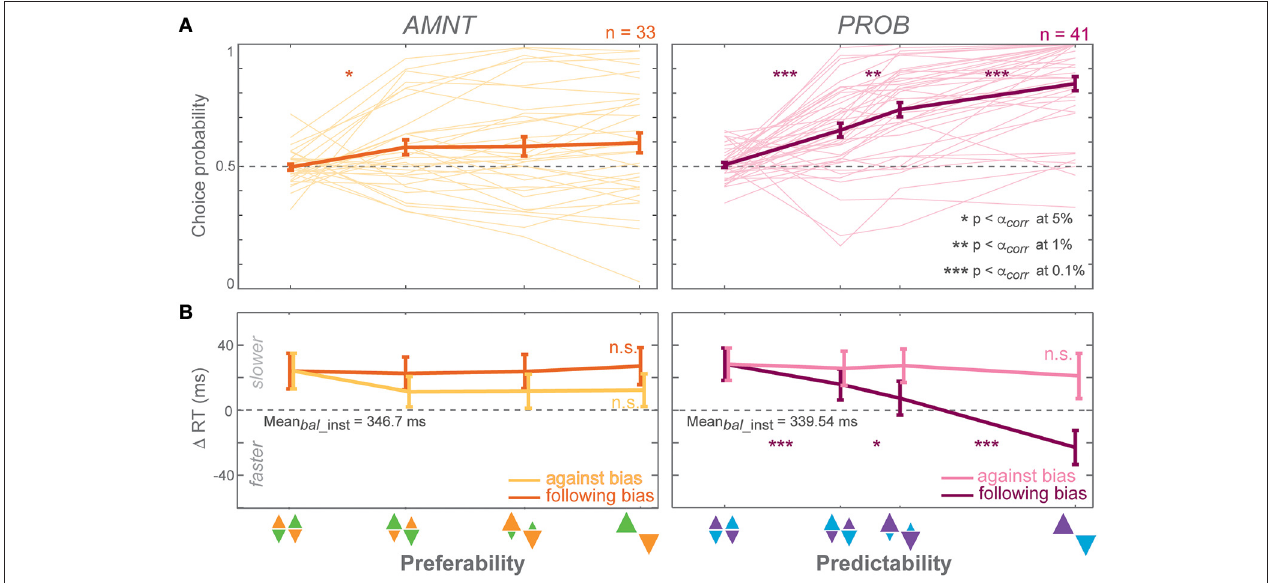
FIGURE 3 | Biasing effects on free-choice responses. (A) Average choice probability (CP): fractions of choice toward the biased direction (at the zero-bias level, as there is no biased direction, fractions of clockwise choice are presented), and (B) average reaction time (RT) difference (zero line indicates average RTs in instructed trials of the zero-bias condition of each task) in all bias levels in AMNT (left) and PROB (right) tasks. Dark and light colors represent follow and against responses, respectively. The error bars represent standard errors. ( * p < α corr at 5%, ** p < α corr at 1%, *** p < α corr at 0.1%, paired t -test with Bonferroni correction).